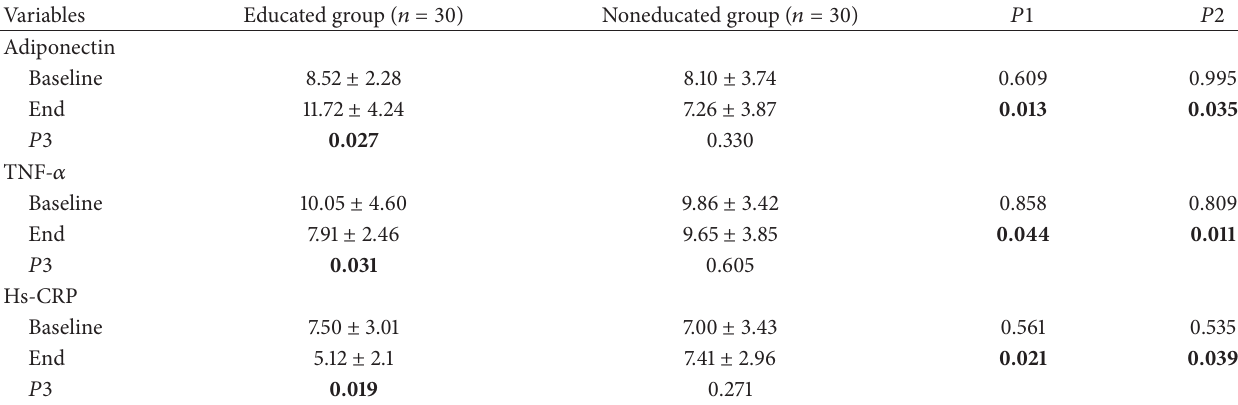
Table 5: Serum levels of inflammatory markers in the study groups at the baseline and end of study.